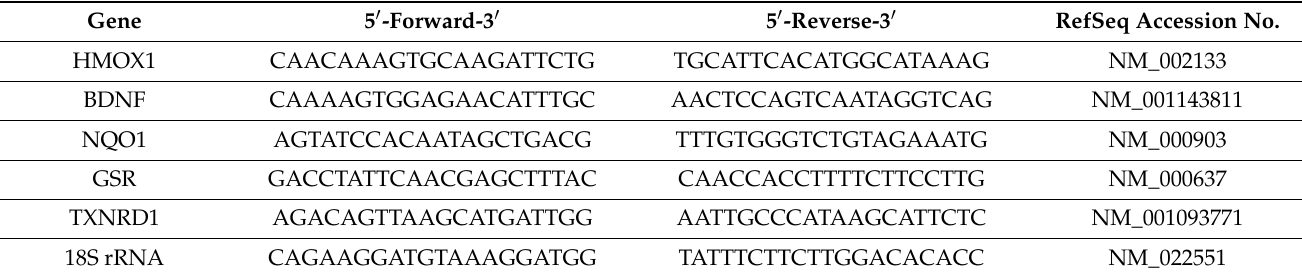
Table 1. List of primers for real-time PCR in SH-SY5Y